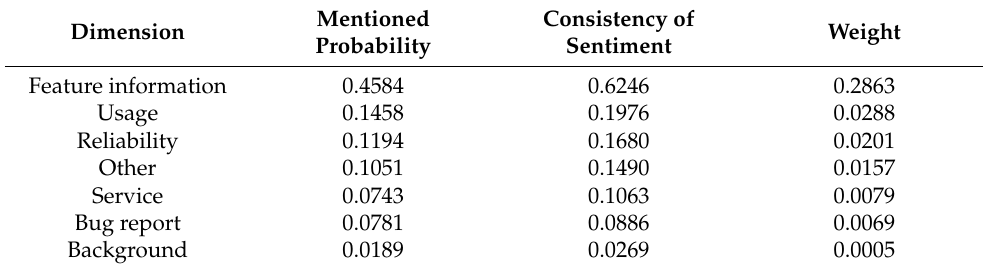
Table 2. Dimension weight table of Ping An Health App.